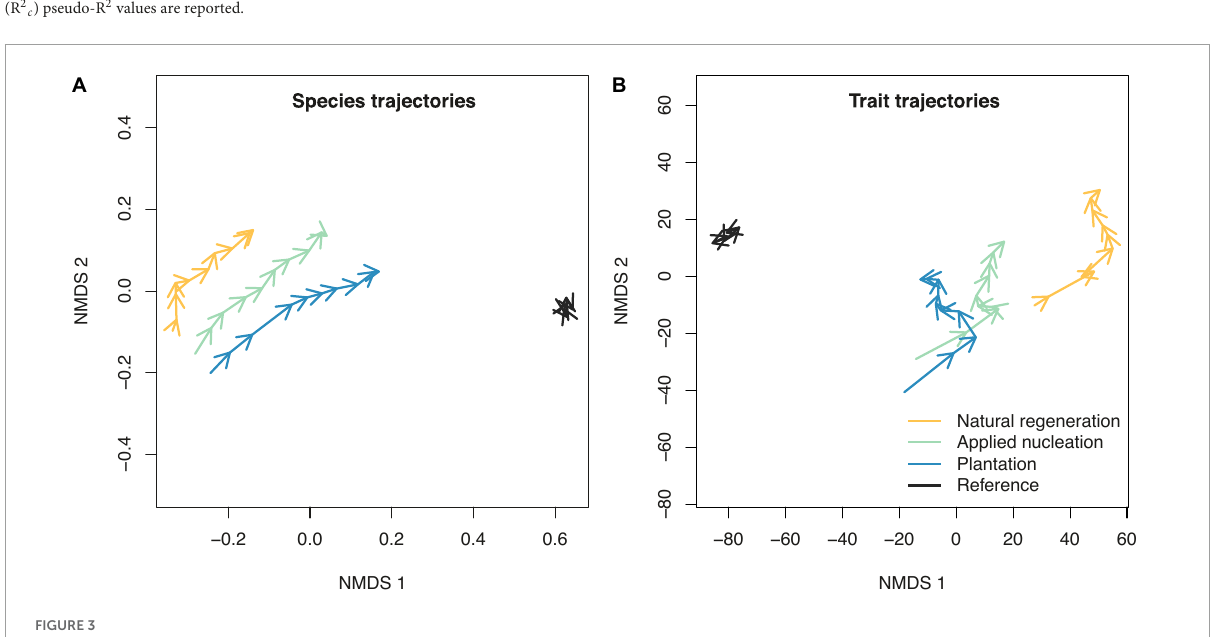
Lower case letters indicate significant differences between treatment means ( α = 0.05) determined by Tukey’s HSD. χ 2 , p-values (bold at α = 0.05) and marginal (R 2 m ) and conditional (R 2